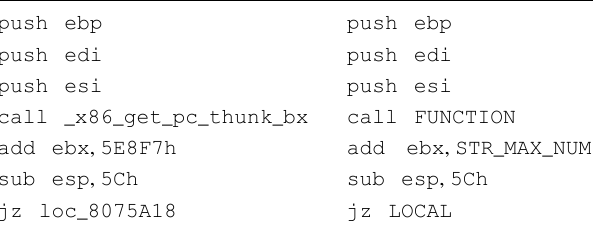
Table 1 The example of semantic attribute embedding